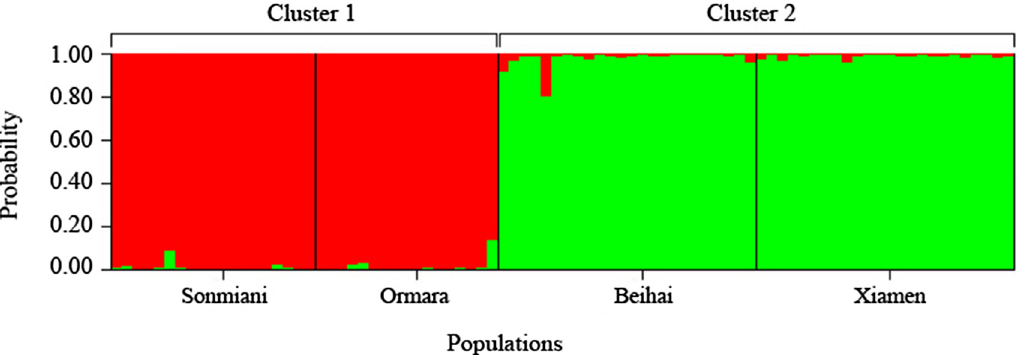
Fig. 5. Results of the STRUCTURE analysis from seven microsatellite loci in P. chinensis ( K =2). Vertical lines are proportional to the probability of individual membership in the simulated cluster.